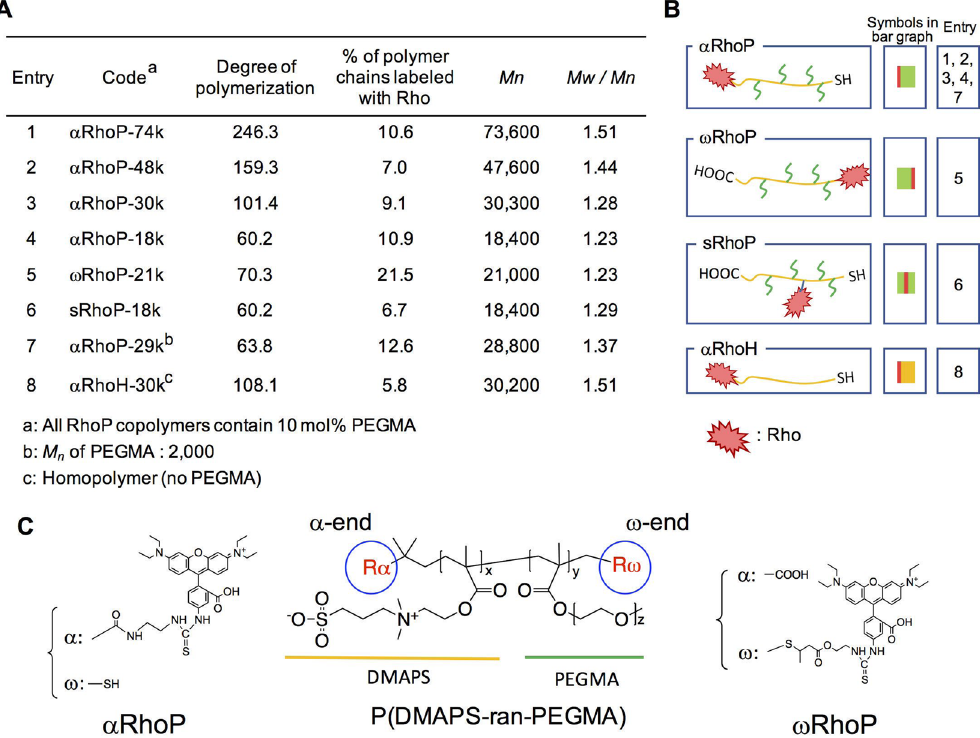
Figure 1. Characteristics and structure of the polymers prepared. ( A ) Table of characteristics for RhoPs. All RhoP polymers contain 10 mol% PEGMA. ( B ) Schematic representation of RhoPs. ( C ) Chemical structure of α RhoP and ω